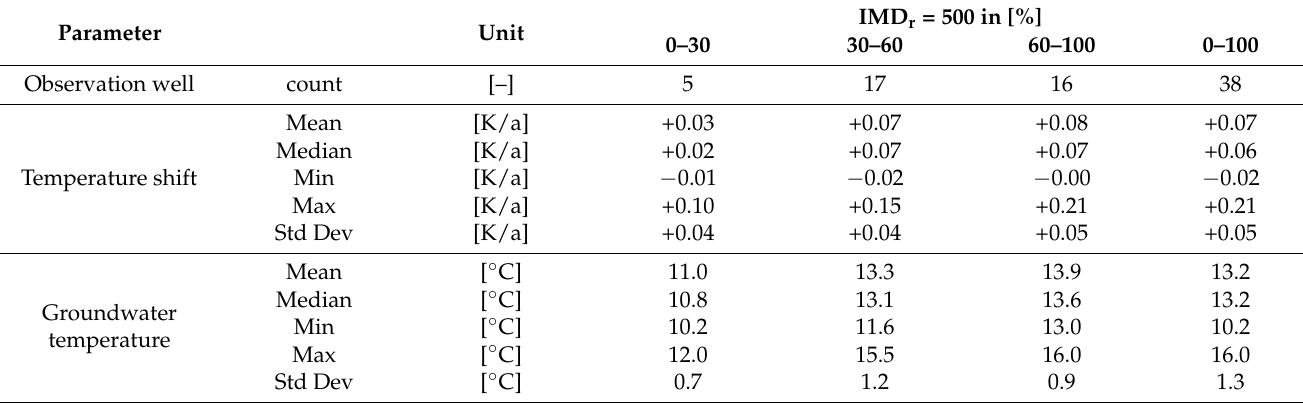
Table 5. Groundwater temperatures and temperature shifts for different IMD sealing classes.